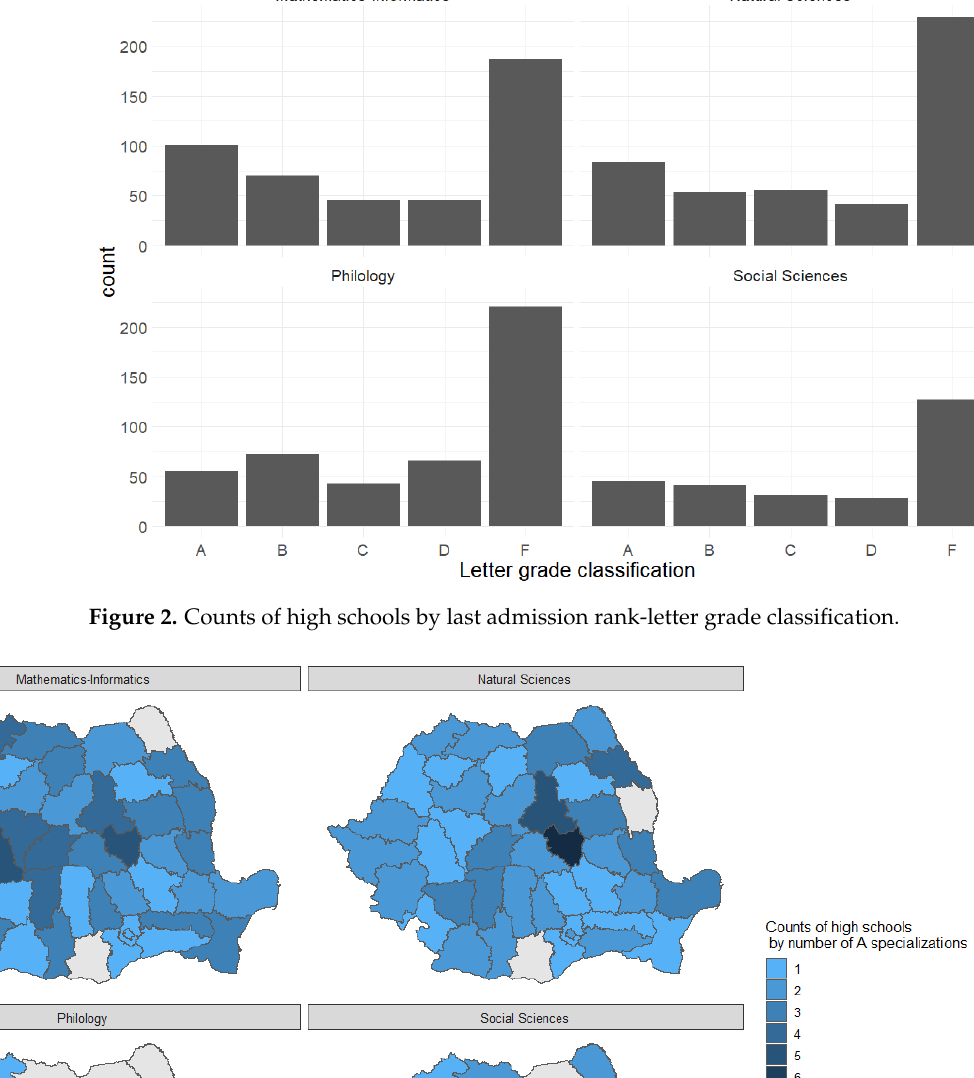
Figure 2. Counts of high schools by last admission rank-letter grade classification.